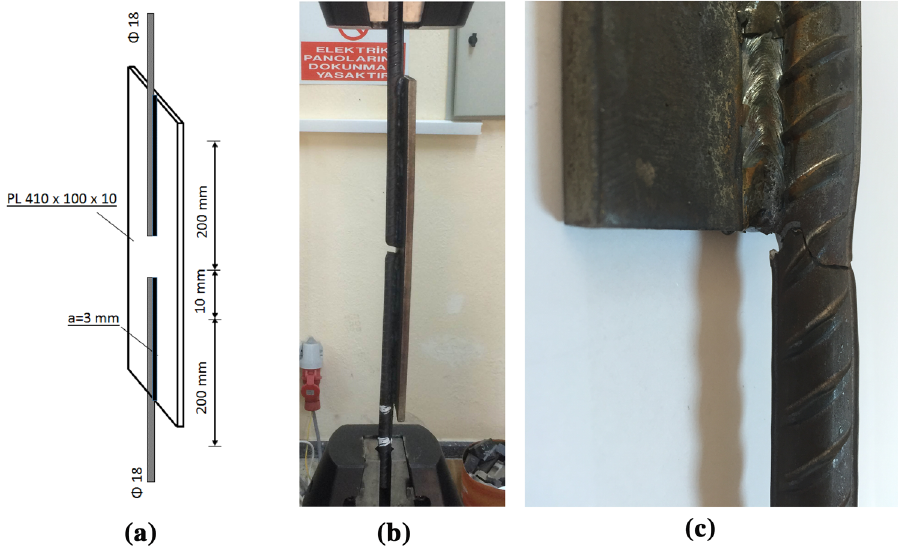
Fig. 2 a Schematic view of welded rebar-plate specimen, b specimen during tensile test, and c rupture of rebar with a clear necked